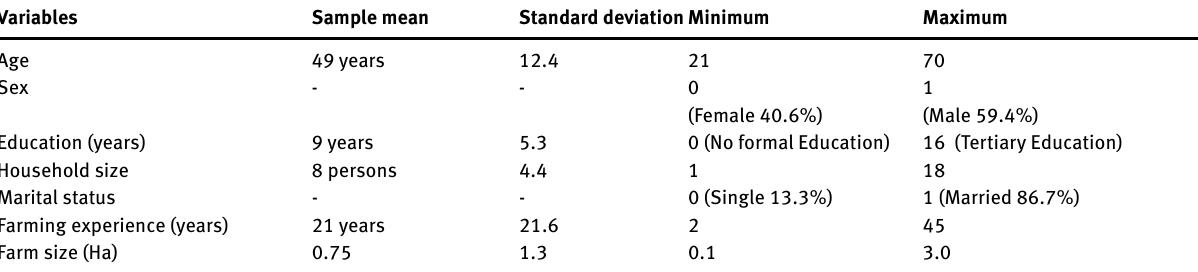
Table 2: Distribution of rice farmers by demographic characteristics